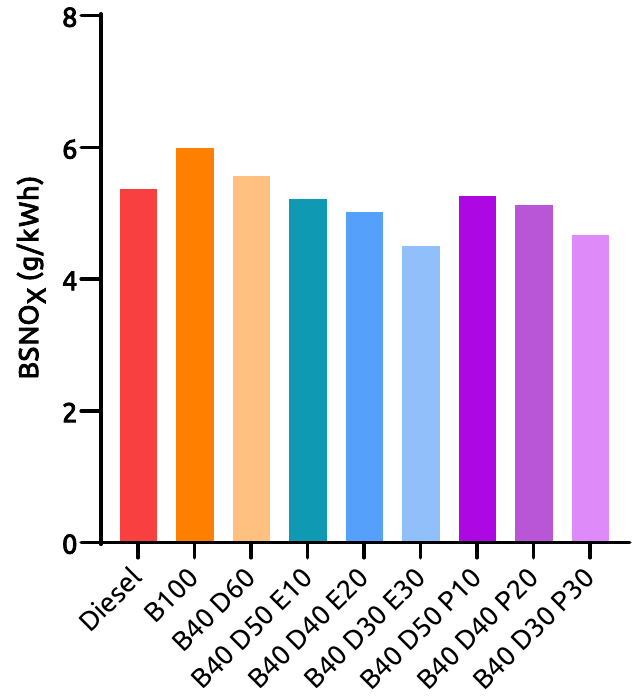
Figure 9. Brake Specific oxides of nitrogen emissions for tested fuels at full engine load. Figure 10 depicts SM data for all tested fuels at 100% engine loading. The SM values are 54.7%, 80.4%, and 75.9% for diesel, B100, and B40D60, respectively. The acquired values for propanol-based ternary blends B40D50P10, B40D40P20, and B40D30P30 are 70.6%, 64.9%, and 60.1%, respectively. Meanwhile, 73.6%, 67.3%, and 63.6% were stated for ethanol-based ternary blends B40D50E10, B40D40E20, and B40D30E30, respectively. When compared with B40D60 binary blend engine operation, B40D50E10, B40D40E20, and B40D30E30 blends presented a decrement of 2.3%, 8.6%, and 12.3%, respectively, while a lower value of 5.3%, 11%, and 15.8% was observed for B40D50P10, B40D40P20, and B40D30P30, respectively. When compared to diesel, both B100 and B40D60 revealed higher SM values by 25.7% and 21.2%, respectively. Prakash et al. [22] also observed similar results in their experiments and reported that lower SM values for ternary blends can be attributed to improved combustion brought about by the decreased viscosity and density of alcohol-containing fuel blends.